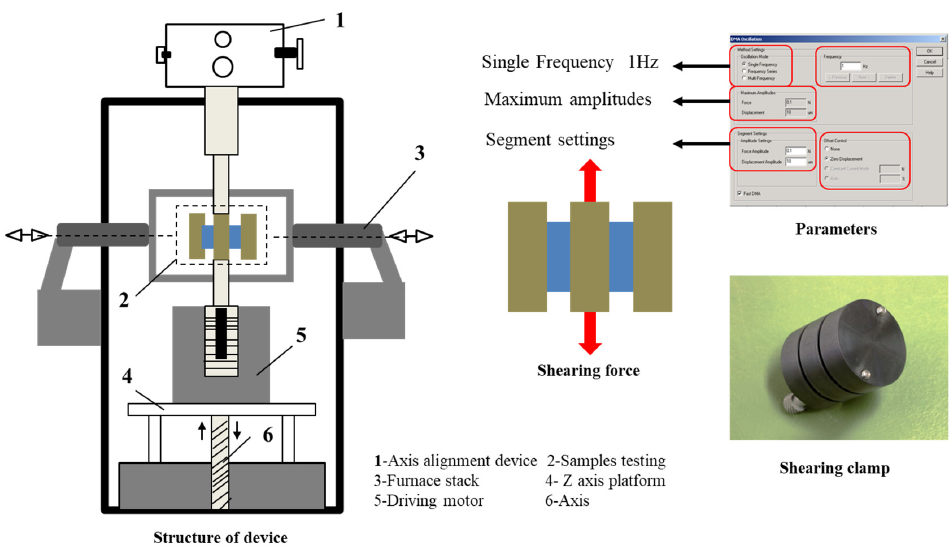
Figure 2. Testing process for the